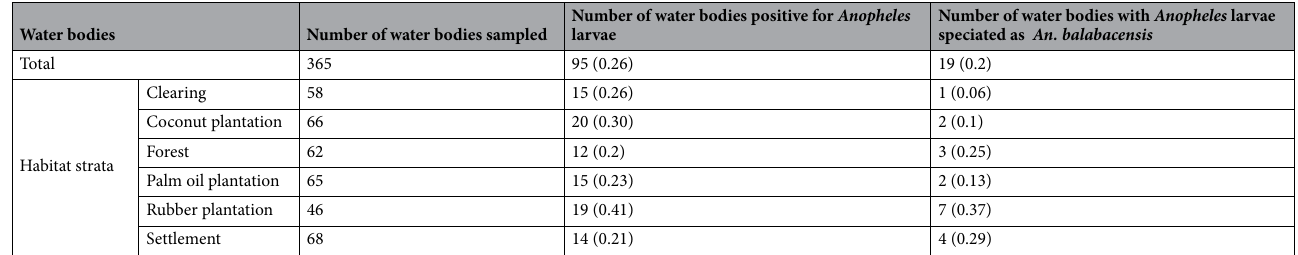
Table 2. Numbers of water bodies sampled and proportions positive for Anopheles larvae by sampling block strata. Proportions included in brackets. Repeated visits to sampling blocks are included in this table.